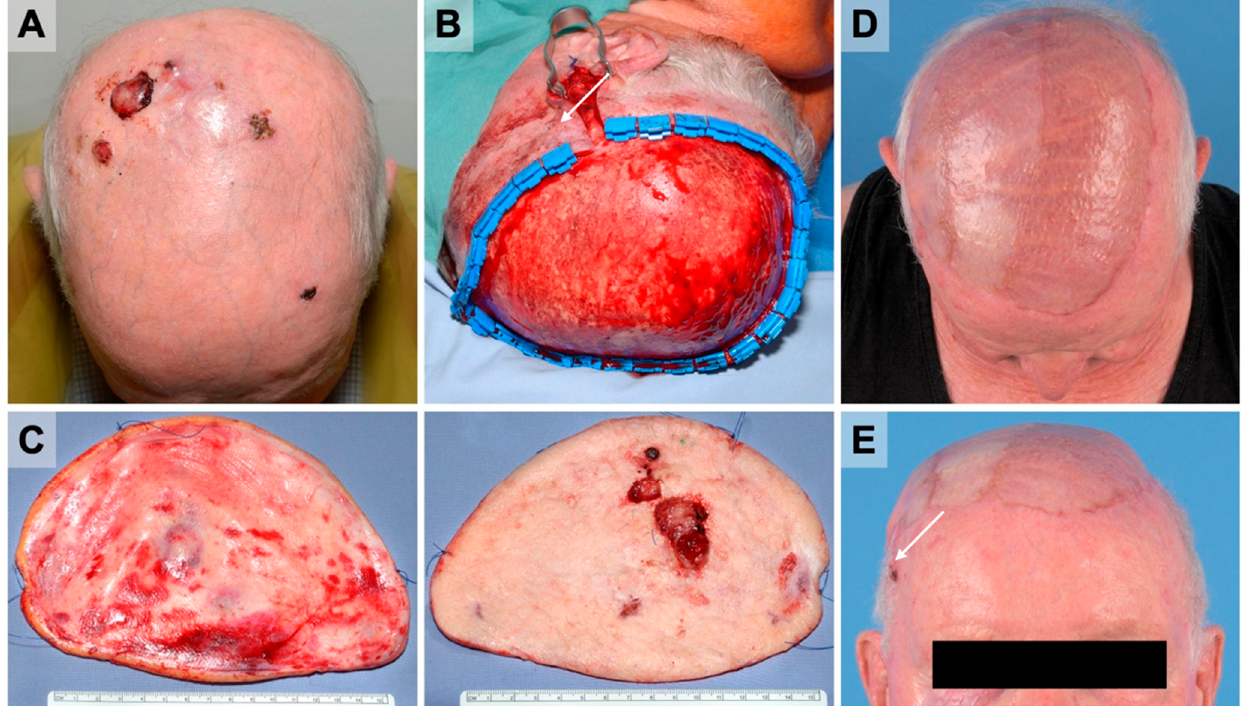
Figure 1. An 81-year-old male patient presented with an external diagnosis of PDS after failed excision biopsy ( A ). ( B ) After wide resection, a full-thickness scalp defect of 221 cm 2 was closed using a latissimus dorsi flap and STSG. ( C ) The resected scalp showed wide tumor-free resections margins (2 cm) and no infiltration of the bone. ( D ) The three-month postoperative control showed satisfying aesthetic results. ( E ) However, a new lesion near the anastomosis had occurred (arrow). The second resection was performed with microscopically positive resection margins. Due to its close proximity to the flap, anastomosis adjuvant radiation was favored and conducted.